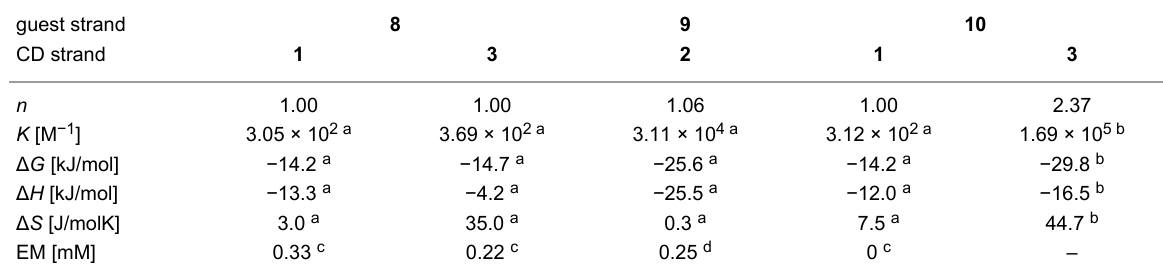
Table 2: Thermodynamic parameters of the interactions of the divalent guest strands 8 , 9 and 10 with complementary and non-complementary diva- lent CD strands. guest